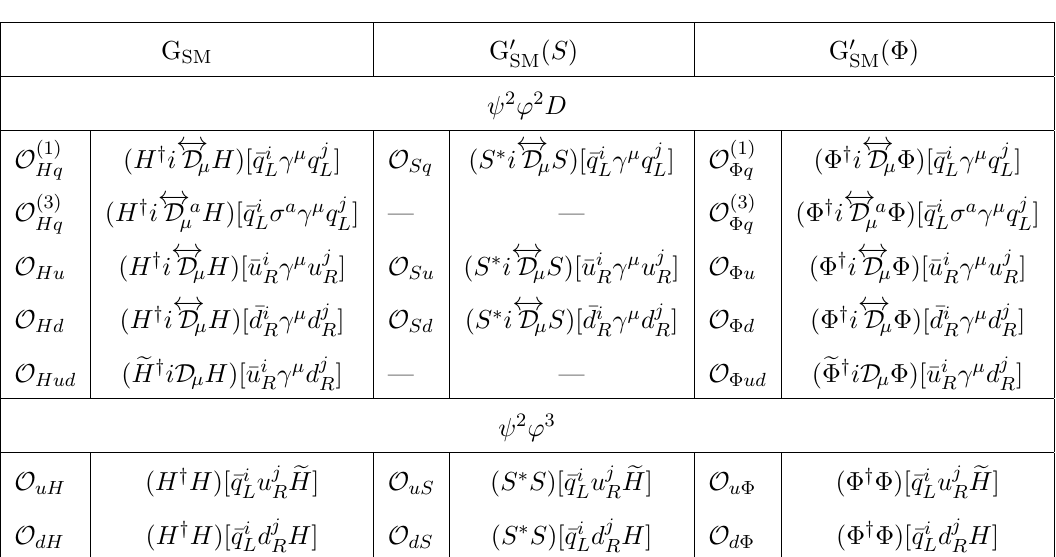
Figure 1. Tree-level graphs (a) and (b) of the decoupling of a VLQ F m that give rise to 2 ’ 2 D operators. They proceed via their Yukawa interactions with scalars ’ = ( H; S; (cid:8)) and SM quarks = ( q L ; u R ; d R ). The gauge boson G (cid:22) depends on the representation. Tree-level graph (c) requires two representations F m;n with a Yukawa coupling via ’ c and give rise to 2 ’ 3 operators.